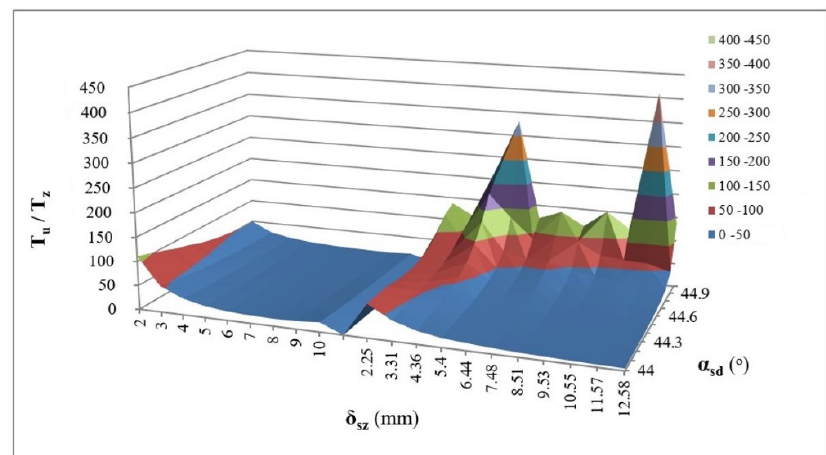
Figure 9. T u /T coefficient for the symmetric model (on the left) and the asymmetric model (on the right).